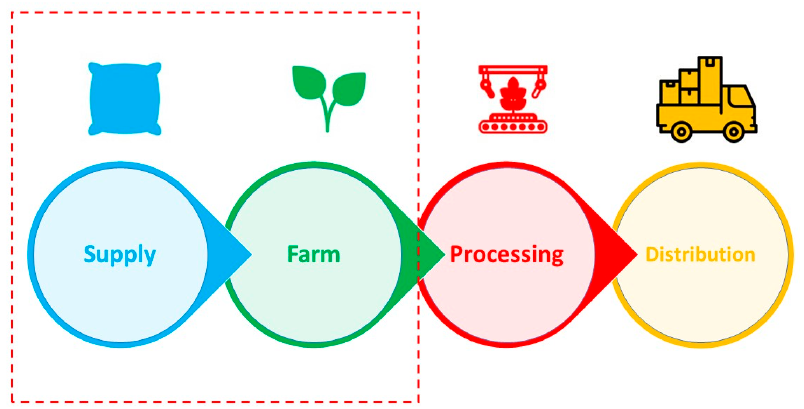
Figure 3. Processes of barley production. The LCA investigated the environmental impact of the farming process. farming